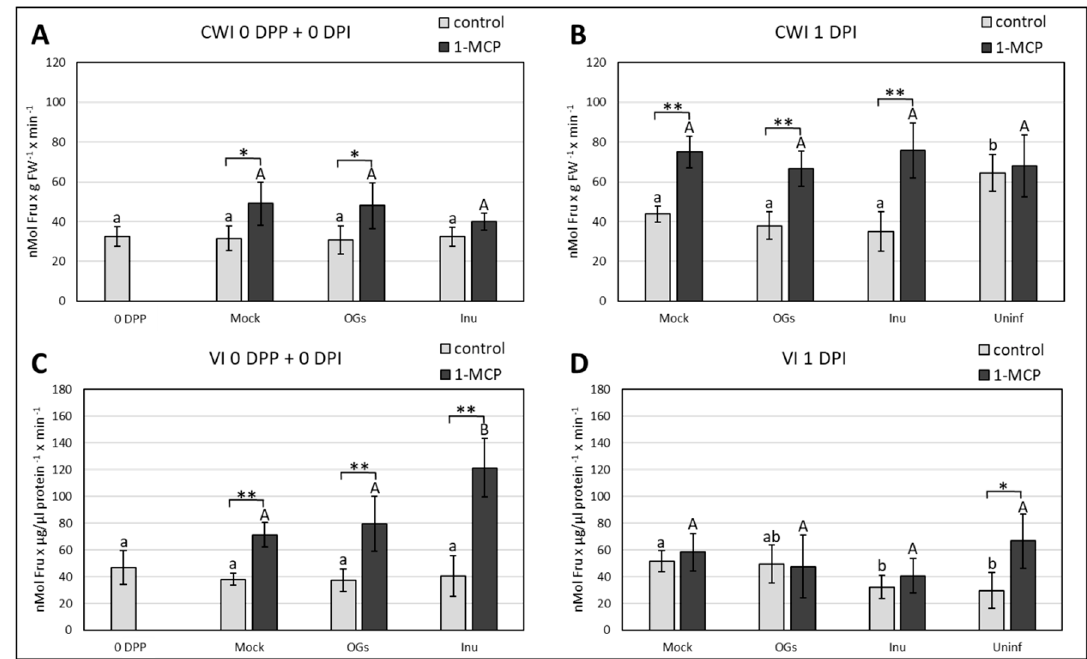
Figure 7. Acidic invertase activities in primed and 1-MCP treated samples. Mock = water-primed leaves; OGs = OGs-primed leaves; Inu = chicory inulin-primed leaves; Uninf = water-primed leaves inoculated with a mock solution (1/2 strength Potato dextrose broth). ( A ) CWI (Cell Wall Invertase) activities at 0 DPP and 0 DPI; ( B ) CWI activities at 1 DPI; ( C ) VI (Vacuolar Invertase) activities at 0 DPP and 0 DPI; ( D ) VI activities at 1 DPI. Bars marked with same letter(s) are not significant between each other, bars that have no letters in common indicate significance between treatments ( p < 0.05, one-way ANOVA followed by Tukey’s post hoc test). Lowercase letters refer to comparison between control treatments, capital letters refer to comparison between 1-MCP treatments. Asterisks indicate significance between control and 1-MCP conditions referring to the same priming treatment (* p < 0.05, ** p < 0.01, Student’s t -test). Values represent the average ± standard deviation of five biological replicates.